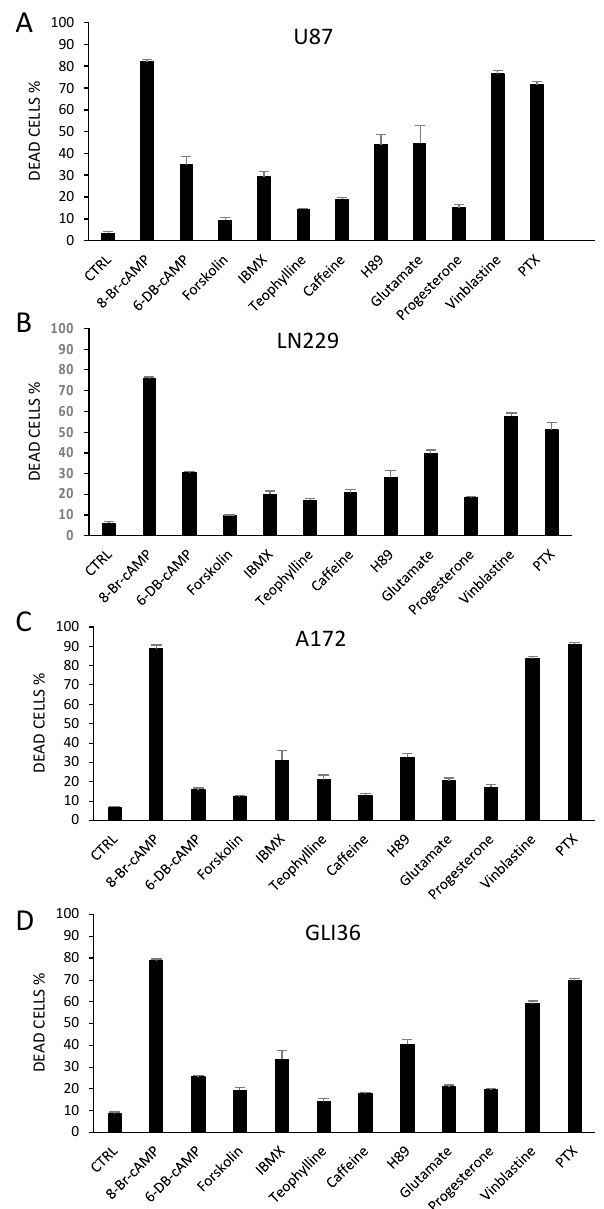
Figure 2. Human glioblastoma cell lines were incubated with the indicated agents for 24 h. ( A ) U87 cell line; ( B ) LN229 cell line; ( C ) A172 cell line; ( D ) GLI36 cell line. The percentage of dead cells was calculated using a total of 2400 cells for each treatment, in each cell line. Mean + S.E. Each treatment in each cell line differs from control (CTRL vs. drug, t -test, p < 0.05). After 24 h, a significant increase in cell death was detected in cells treated with agents directly acting on PKA, as well as with pro-apoptotic or antiblastic agents (glutamate, or vinblastine and paclitaxel, respectively). CTRL: control; cAMP: cyclic AMP; IBMX: isobutylmethylxanthine; PTX: paclitaxel.